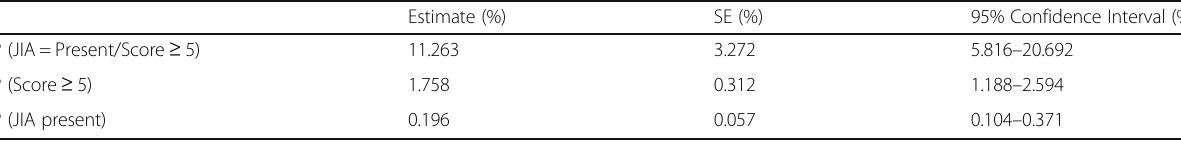
Table 2 Estimation of the JIA prevalence in the city of São Paulo Estimate (%) SE (%) 95% Confidence Interval (%) P (JIA = Present/Score ≥